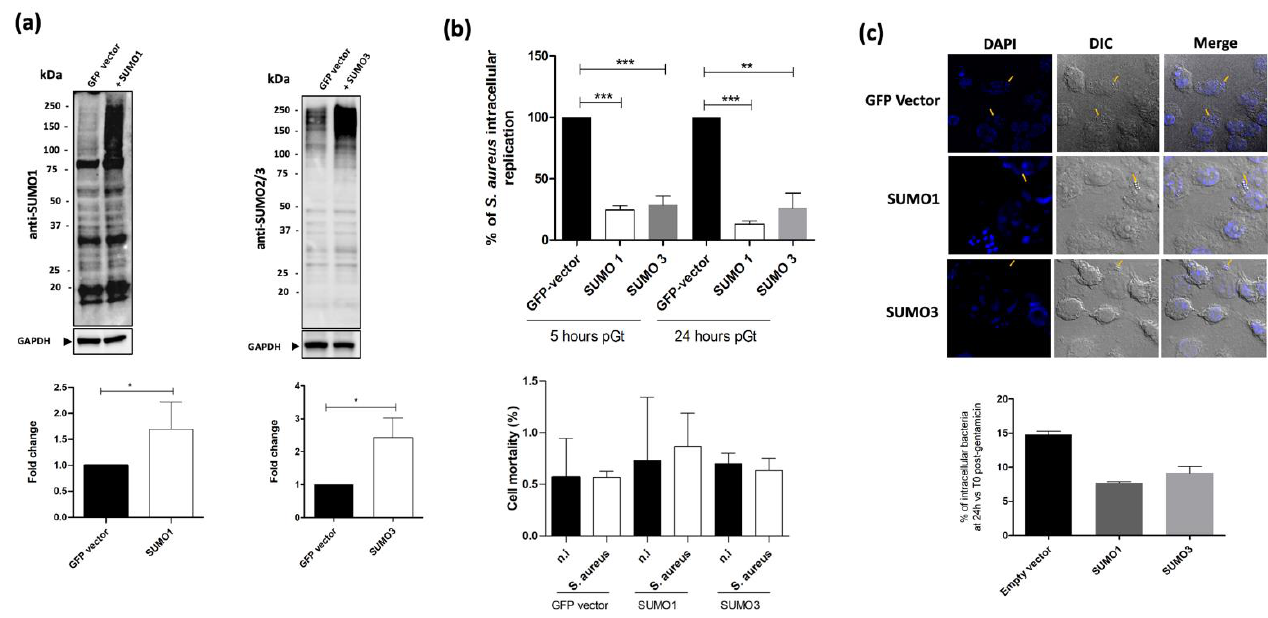
Figure 3. SUMOylation over-expression decreases the intracellular survival of S. aureus . ( a ) Immunoblot analysis of SUMO1 (left panel), or SUMO2/3 (right panel) over-expressing macrophages versus control macrophages (GFP vector). GAPDH levels in lysates were used to standardize protein amounts. SUMO1 and SUMO2/3 smears were detected using Image lab software (ChemiDoc) and normalized to GAPDH (bottom panels). ( b ) Intracellular S. aureus number recovered from macrophages overexpressing SUMO was counted after cell lysis and is presented as the ratio of intracellular bacteria at 5 h and 24 h post-gentamicin compared to cells transfected with an empty GFP vector, considered as 100%. Cell mortality was assessed using trypan blue exclusion dye 0.4% ( w / v ) to evaluate the number of blue (dead) cells. ( c ) Representative confocal images of infected macrophages with S. aureus for 24 h pGt. Arrows show intracellular bacteria. The percentage of intracellular bacteria in macrophages overexpressing SUMO1, SUMO3, or GFP vector is represented as the ratio of intracellular bacteria at 24 h vs. T0 pGt and is the result of independent counting of 100 cells from each of three independent experiments. DIC: differential interference contrast. *** p ≤ 0.001; ** p ≤ 0.01; * p ≤ 0.05 by one-way ANOVA with Bonferroni’s multiple-comparison